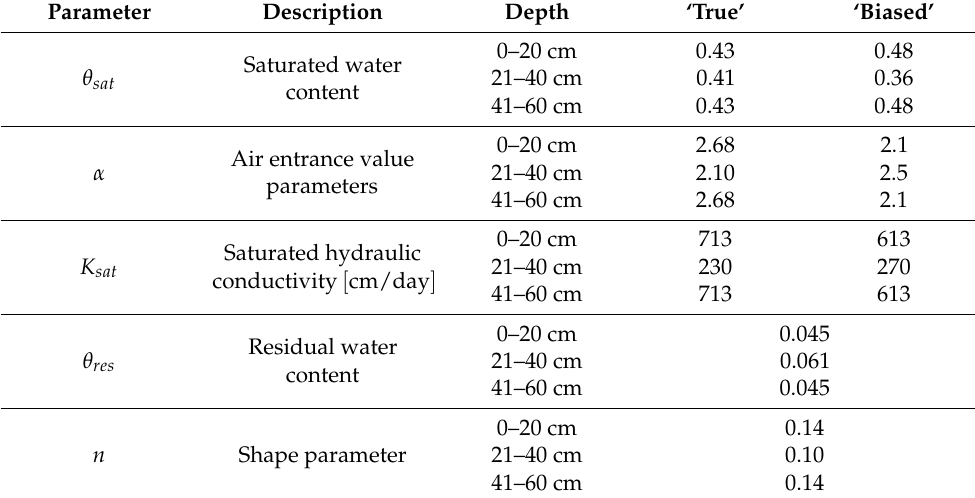
Table 1. The soil parameters used in the case